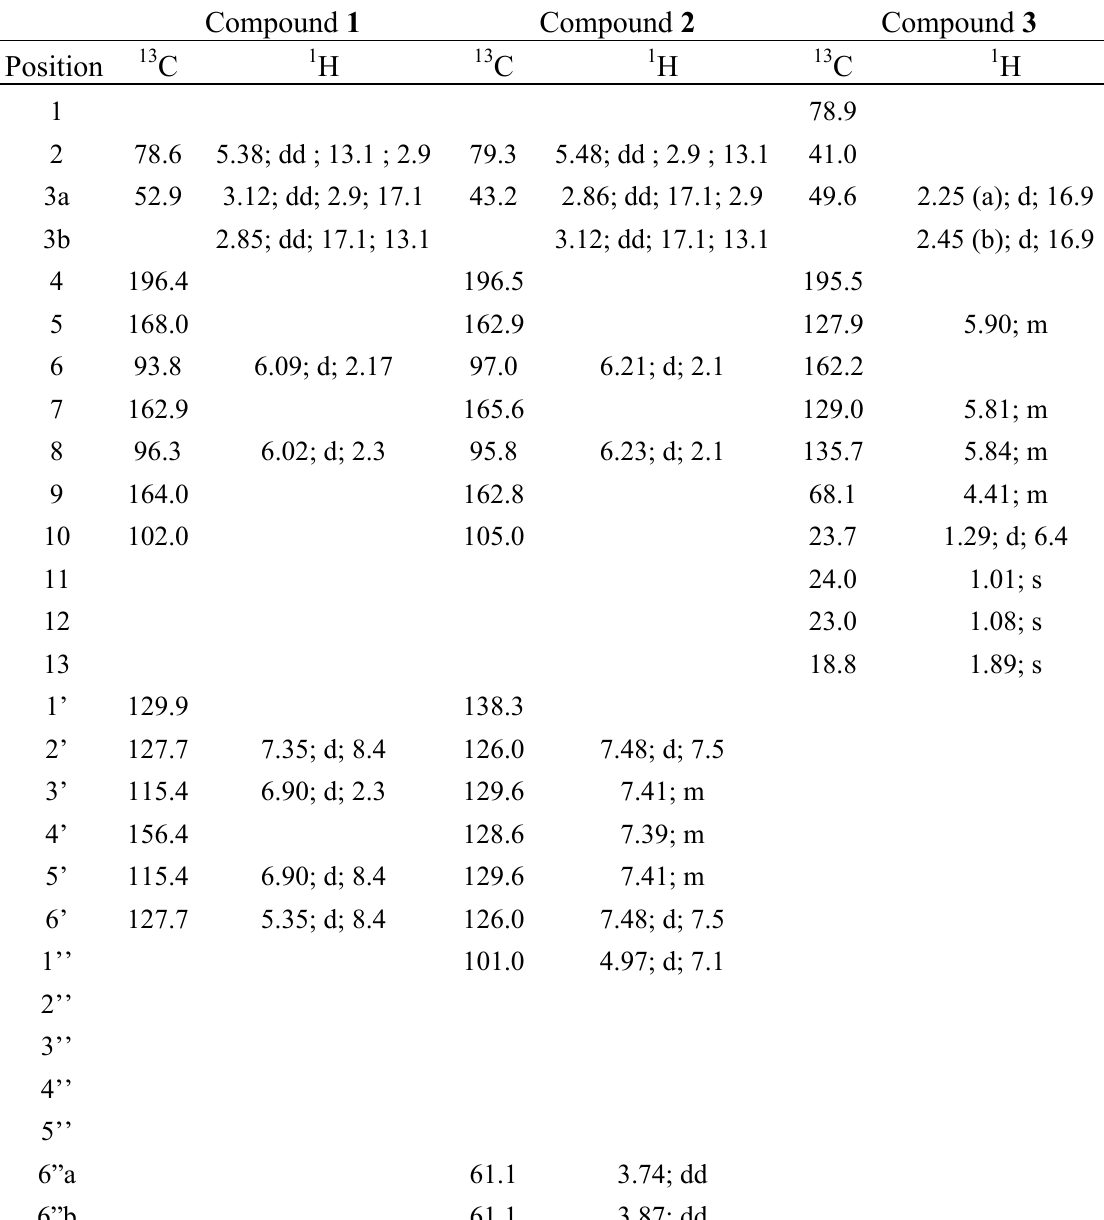
Table 1. 1 H- and 13 C-NMR spectral data for compounds 1 , 2 and 3